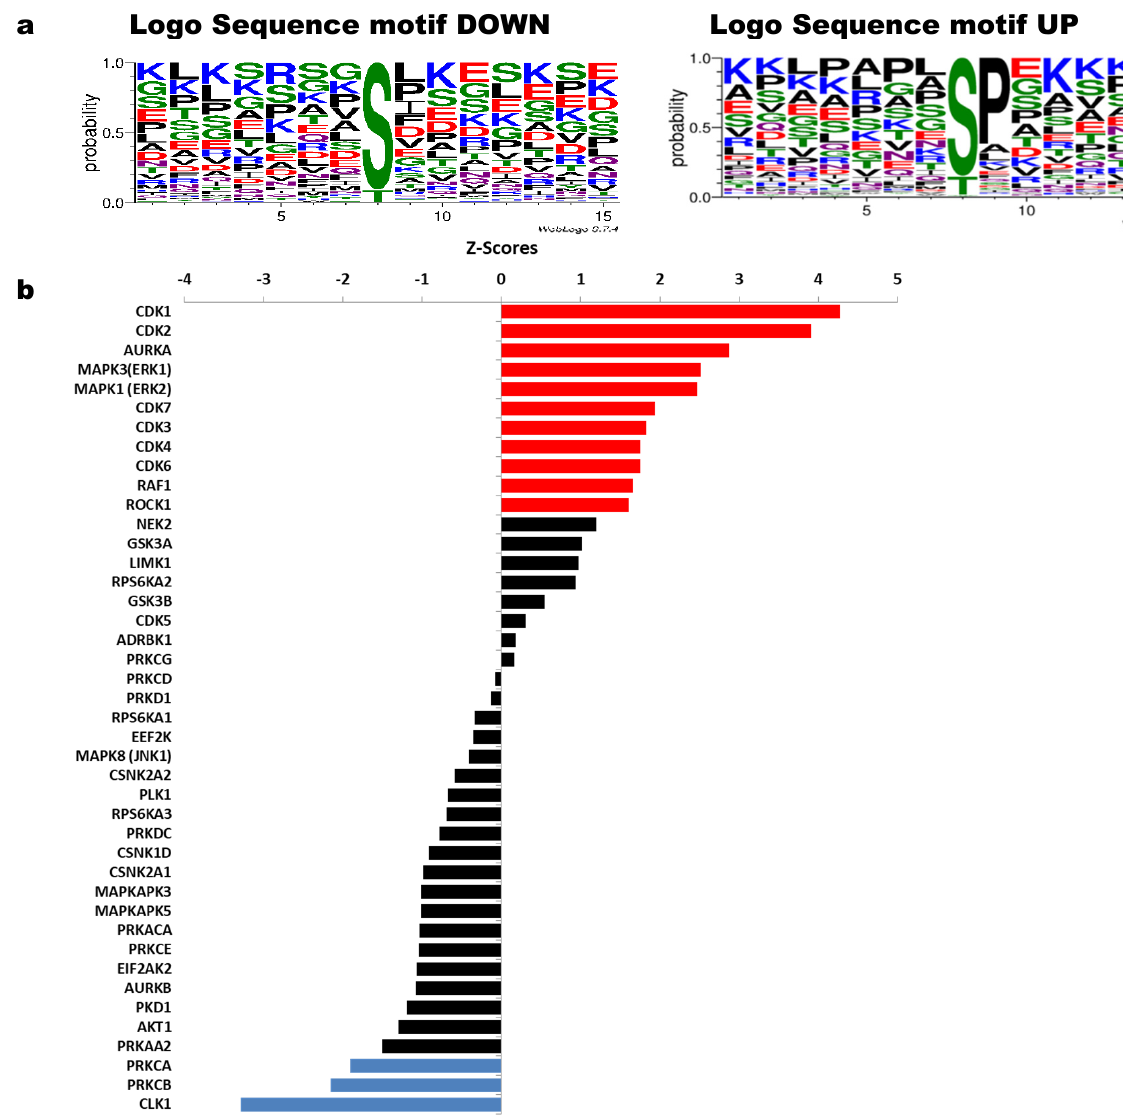
Figure 4. Sequence motifs logo and kinases analysis from phosphosites with increased or decreased phosphorylation after U-87 MG treatment with HeberFERON. ( a ) Logo Sequence motifs found for phosphosites that increased (UP) and decreased (DOWN) phosphorylation using WebLogo 3.7.4 ( b ) Analysis of kinases using the KSEA tool taking into account phosphosites which are statistically regulated; red (for sites with increased phosphorylation) and blue (for sites with decreased phospho- rylation) for kinases with Z scores with statistically significance p < 0.05; in black, other kinases with p > 0.05 were also tabulated according to their Z score. Gene symbols are